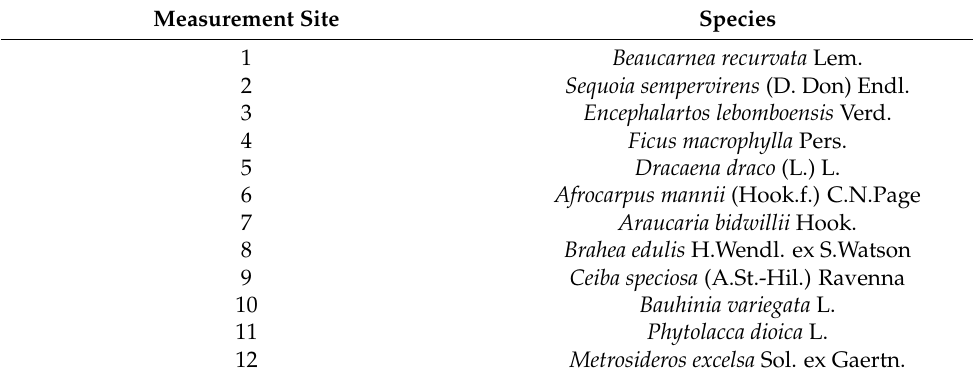
Table 5. Measurement sites and species. Measurement Site